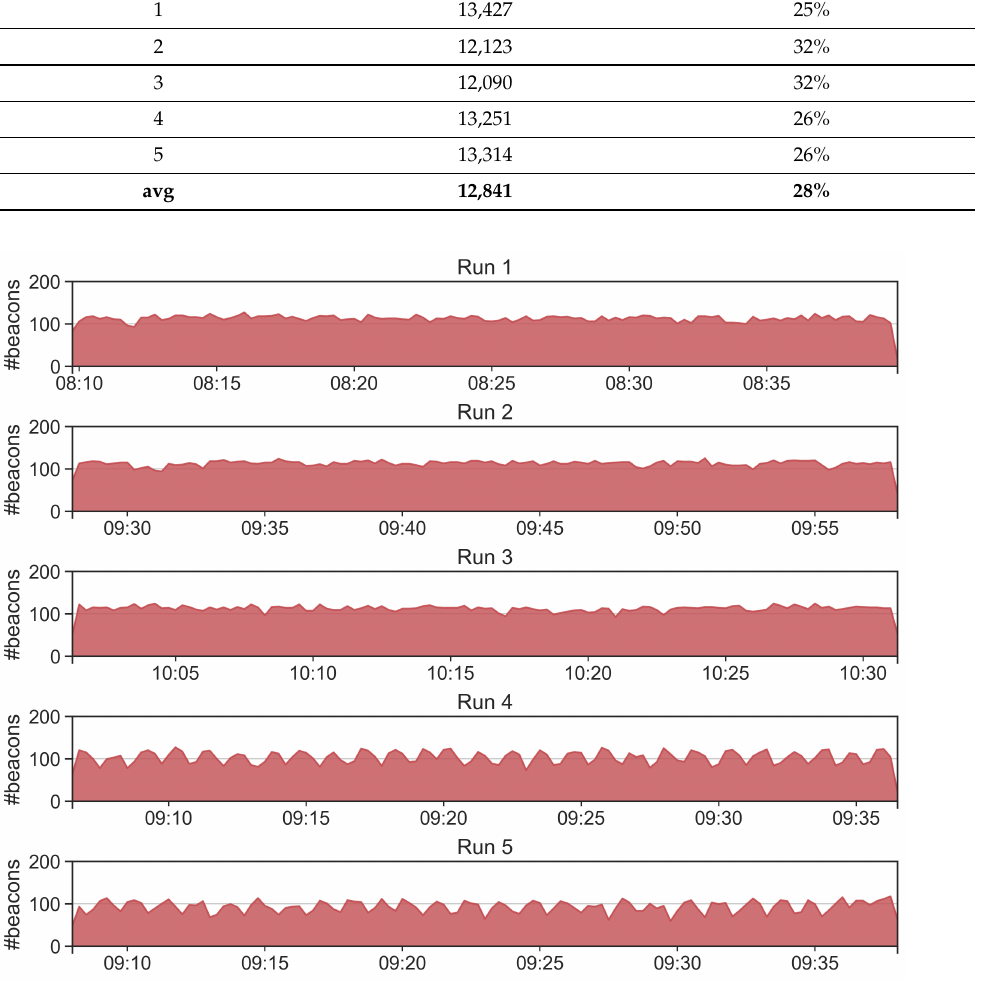
Figure 6. Number of beacons collected in T 1 for each